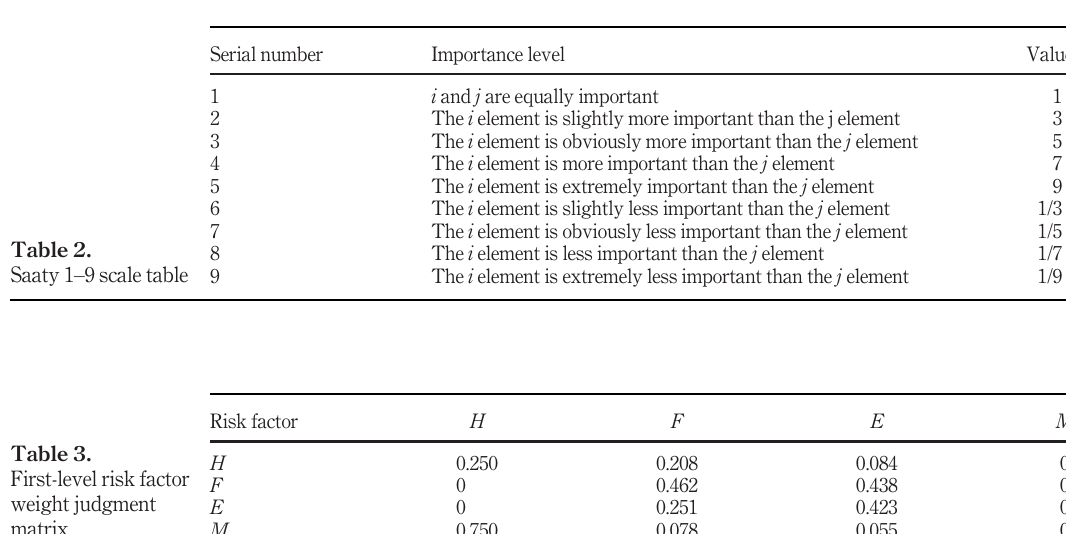
Table 3. First-level risk factor weight judgment